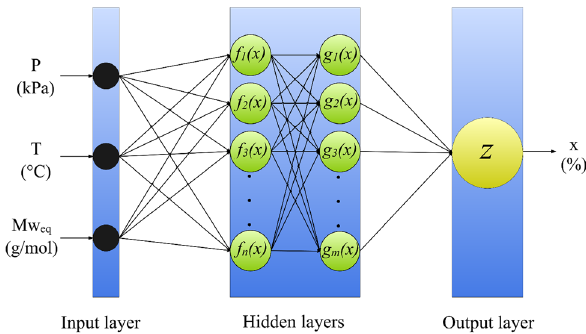
Figure 2. The structure of the MLP network employed for modeling of H 2 S solubility (created by Grapholite 4.0.1 90 ).